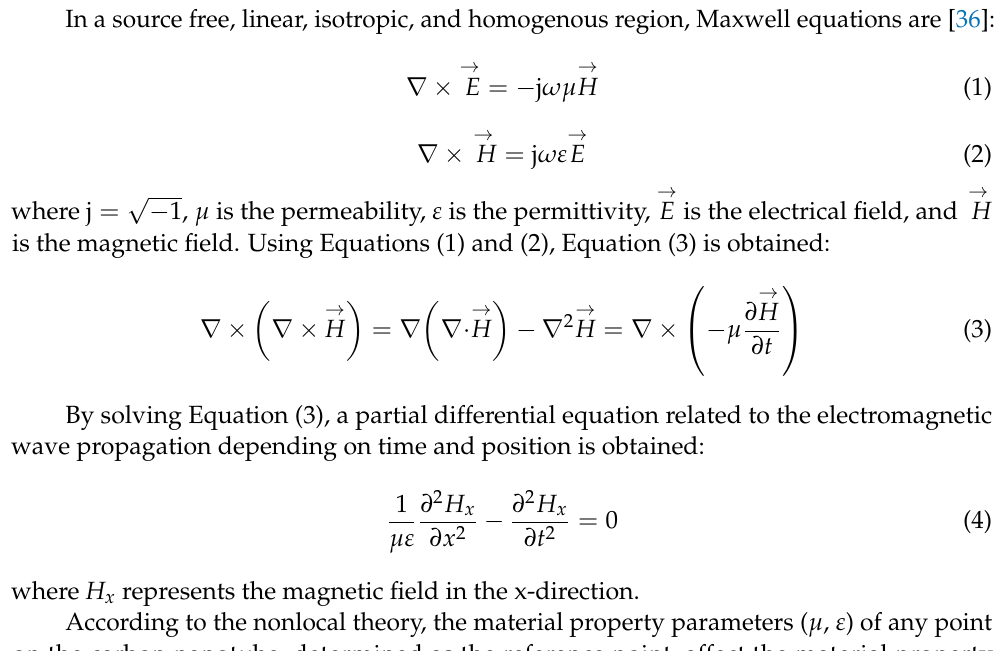
Figure 1. ( a ) EM wave propagation in the DWCNT, ( b ) EM interaction between DWCNT’s inner and outer